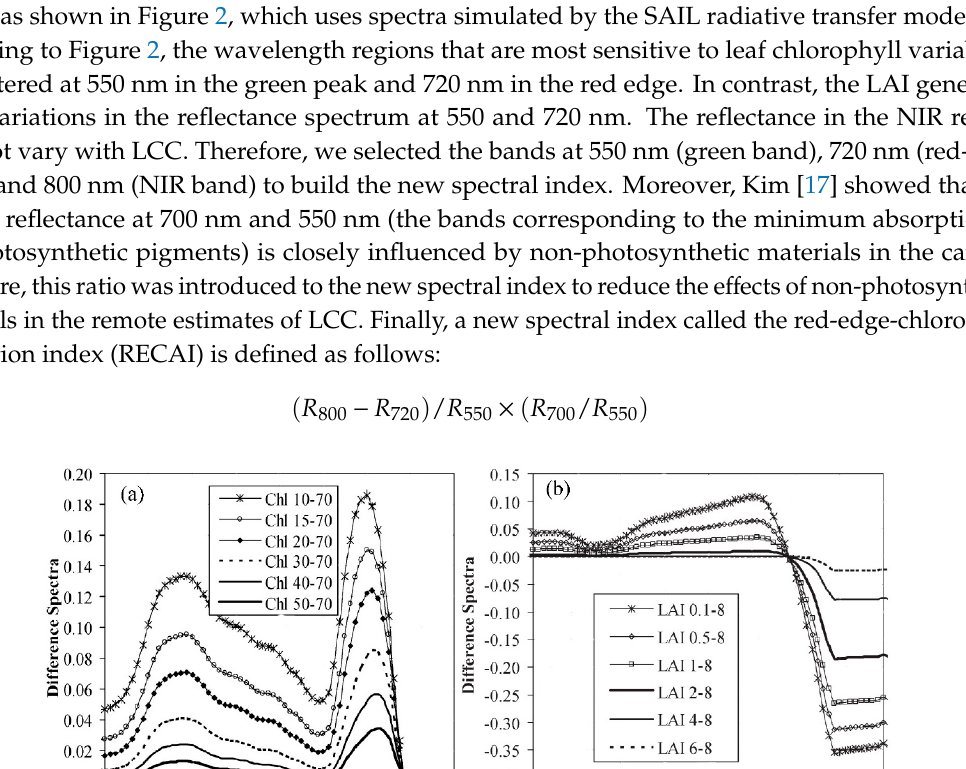
Figure 2. Relative difference in canopy reflectance [15]. ( a ) Difference between reflectance spectra corresponding to various chlorophyll contents and reflectance spectra corresponding to LCC = 70 μ g cm − 2 . In the legend, Chl 30–70 is the difference between the reflectance spectra corresponding to LCC